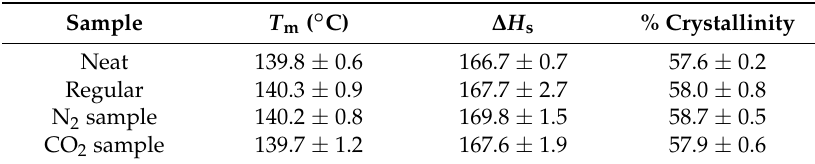
Table 4. The average thermal behavior of injection-molded samples obtained from the second Table 3. The average thermal behavior of injection-molded samples obtained from the first heating heating thermograms.